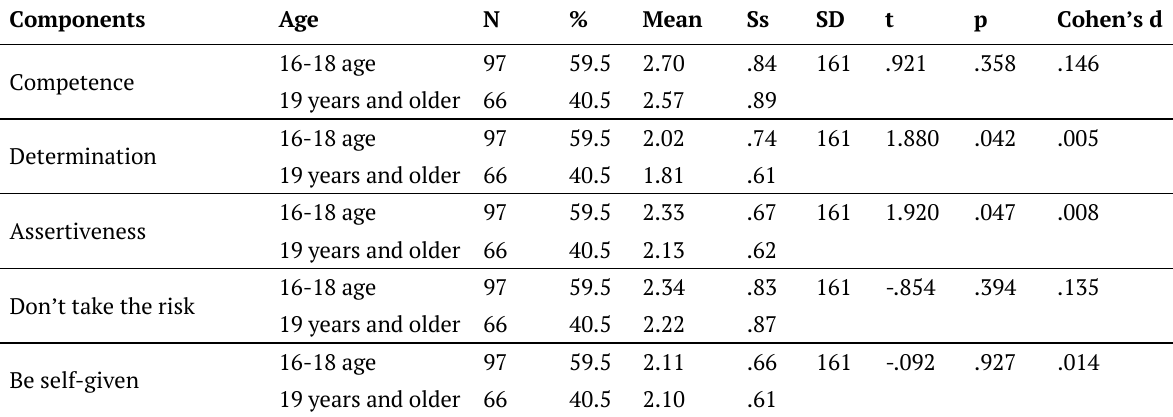
Table 2. T-test results of courage and sub-dimensions in sports according to age variable N=163. Components